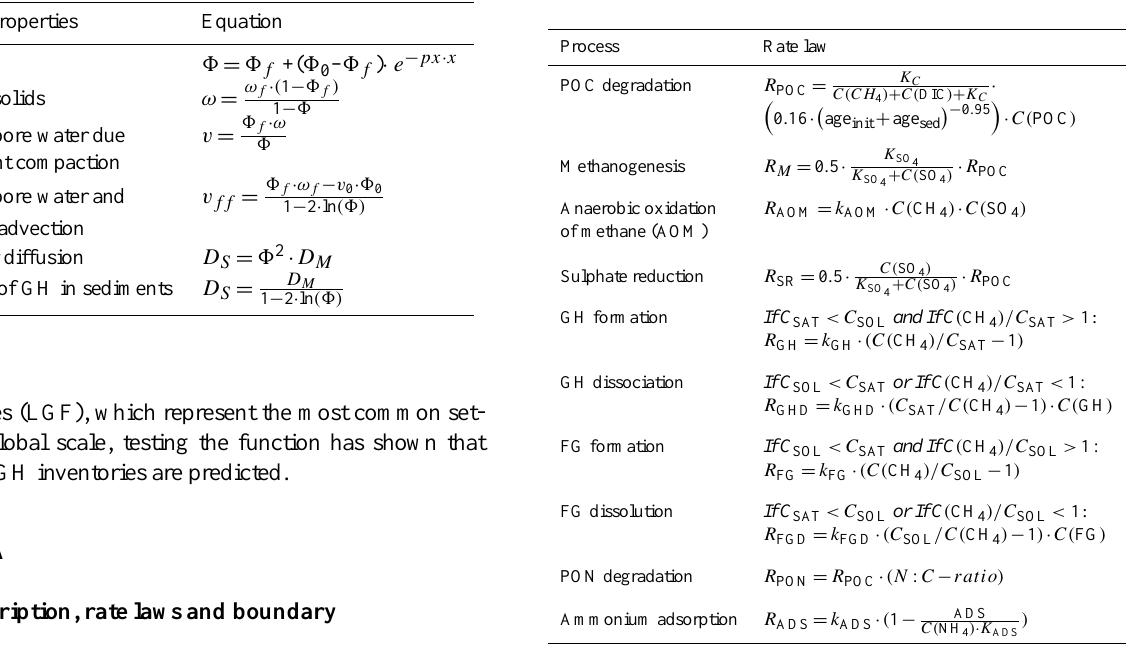
Table A1. Summary of the physical properties. Table A2. Summary of the rate laws of processes used in the mod-